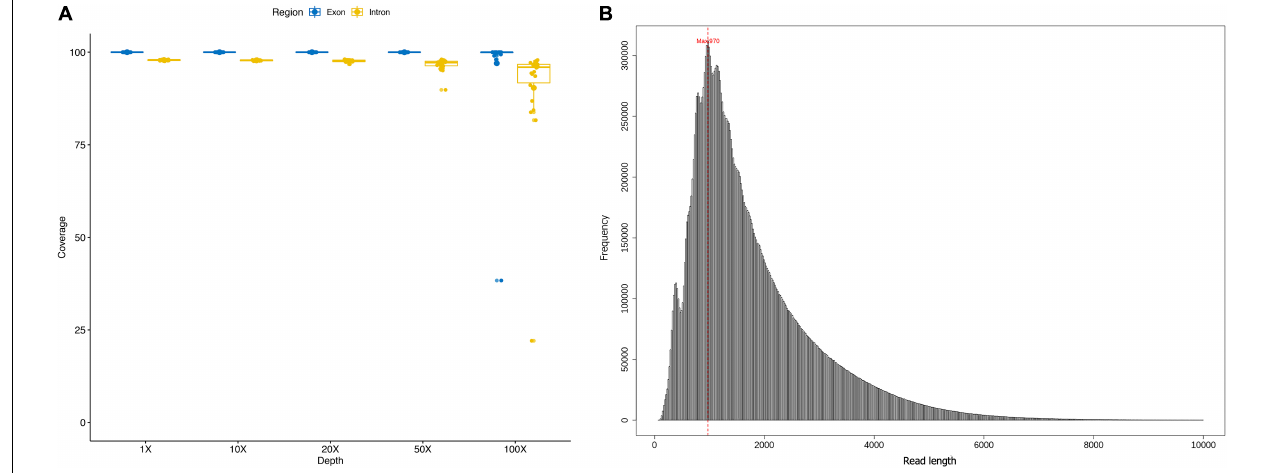
Intron 44 Structure Characteristics